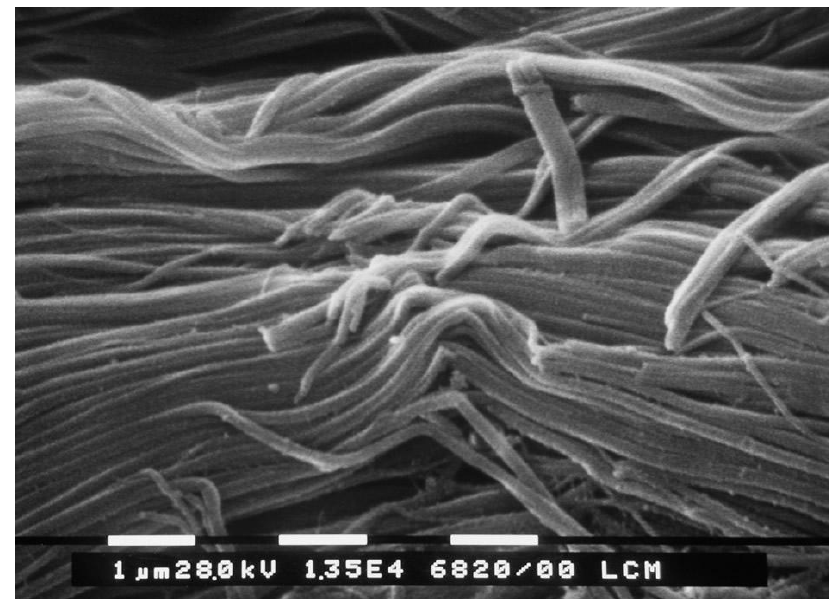
FIGURE 4. Rat medial collateral ligament incubated in ChABC observed at SEM. In the fibrillar crimp region, each fibril first twists on the left, changing the plane of direction, and then sharply bends, changing the direction of its course. Bar = 1